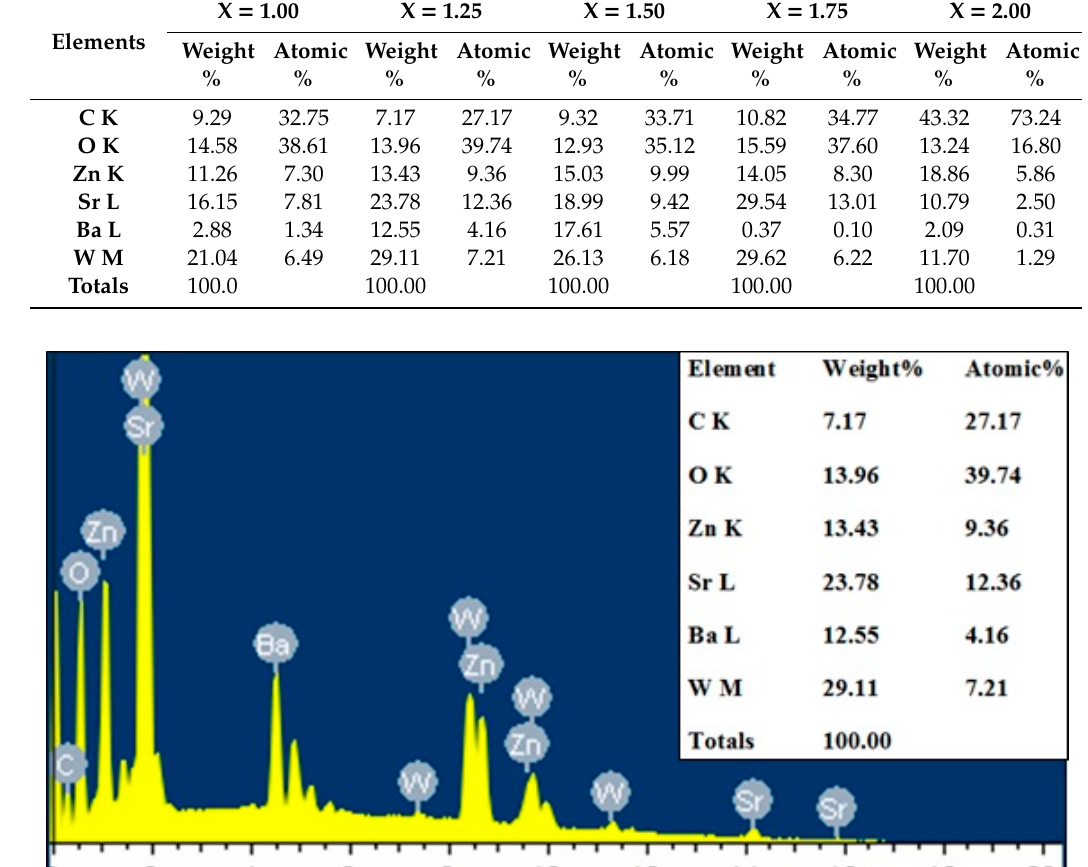
Table 3. The EDX results for the Ba 2 − x Sr x ZnWO 6 (x = 1, 1.25, 1.50, 1.75, 2.00) double perovskite series samples.